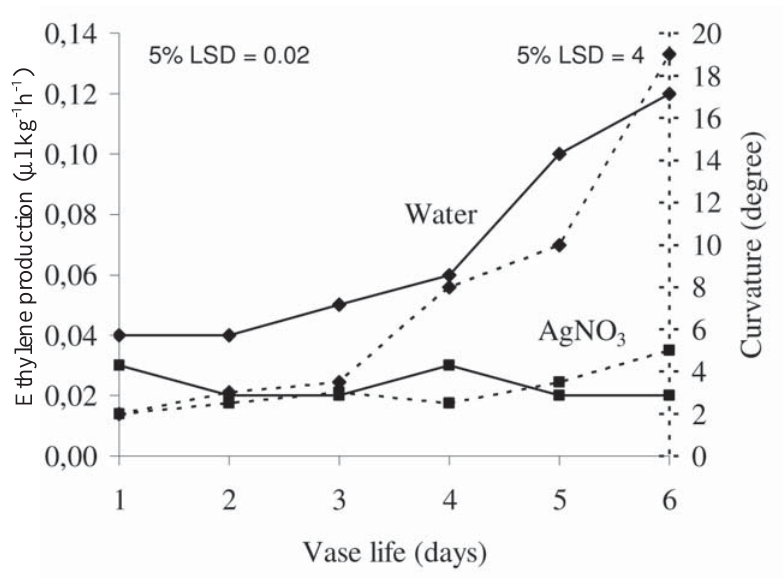
Fig. 5. Trends of ethylene production (continuous line) and degree of curvature (dotted line) of cultivar Provence flowers during vase